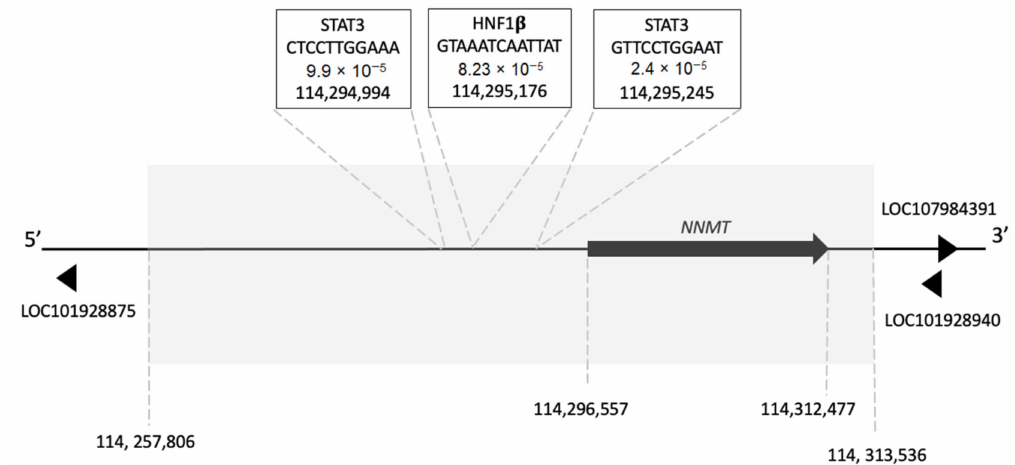
Figure 4. Schematic representation of the NNMT genomic neighbourhood showing the position of putative STAT3 and HNF-1 transcription binding sites (TFBS) and three lncRNAs. Sites were predicted in FIMO with p -values for each predicted TFBS given below the retrieved motif. Coordinates of all features taken from GRCh38.p13 (accession NC_000011.10). lncRNAs are indicated with “LOC” numbers. Shaded area = NNMT gene regions. Arrows are not drawn to